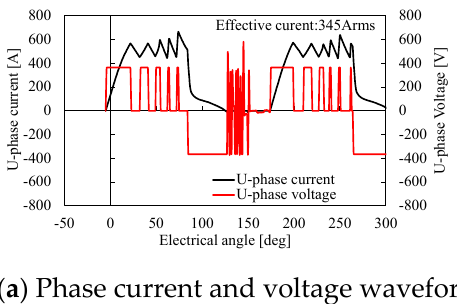
Figure 13. Rotation speed of 11,500 min -1 , turn-on angle of − 5 degrees, and turn-off angle of 85 degrees.